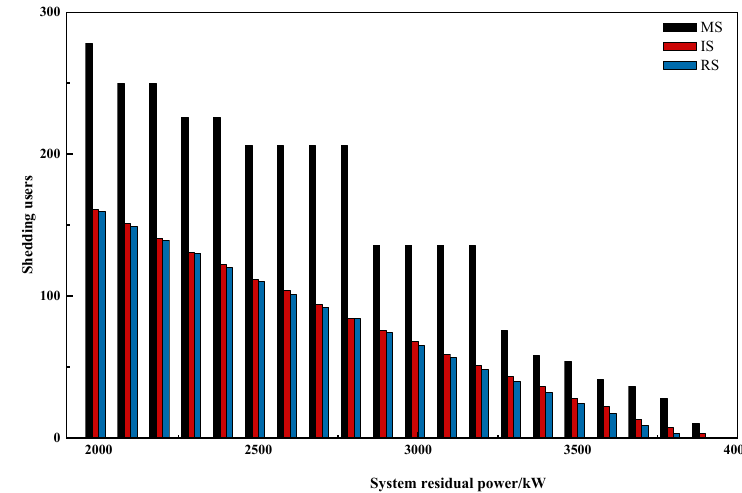
Figure 8. Comparison of the total shedding users after the load shedding.